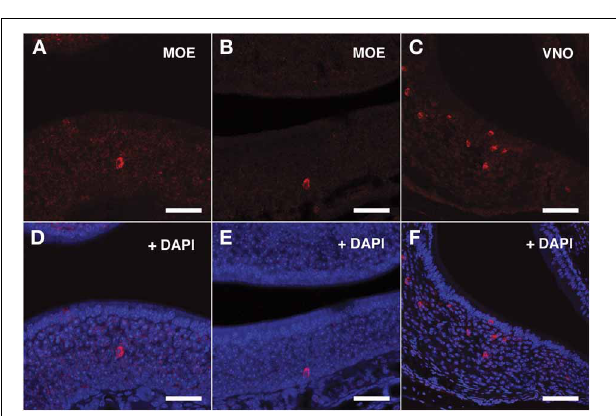
FIGURE 3 | In situ hybridization with Vmn1r201 riboprobes on serial sections of the MOE. (A,B) Several cells throughout the MOE are revealed by the antisense Vmn1r201 riboprobe. These cells are mainly found in the middle and basal layers of the MOE. The control sense probe for Vmn1r201 did not display any detectable staining in the MOE or VNO. (C) The Vmn1r201 antisense riboprobe hybridizes as expected with a high number of cells throughout the VNO. (D–F) Panels (A–C) merged with stained nuclei (DAPI). Scale bars: 60 μ m.